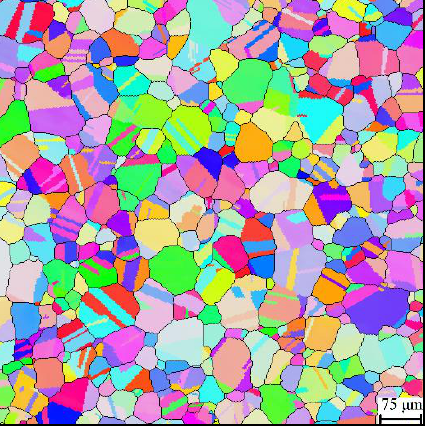
Figure 1. Initial grain structure for grain growth tests.